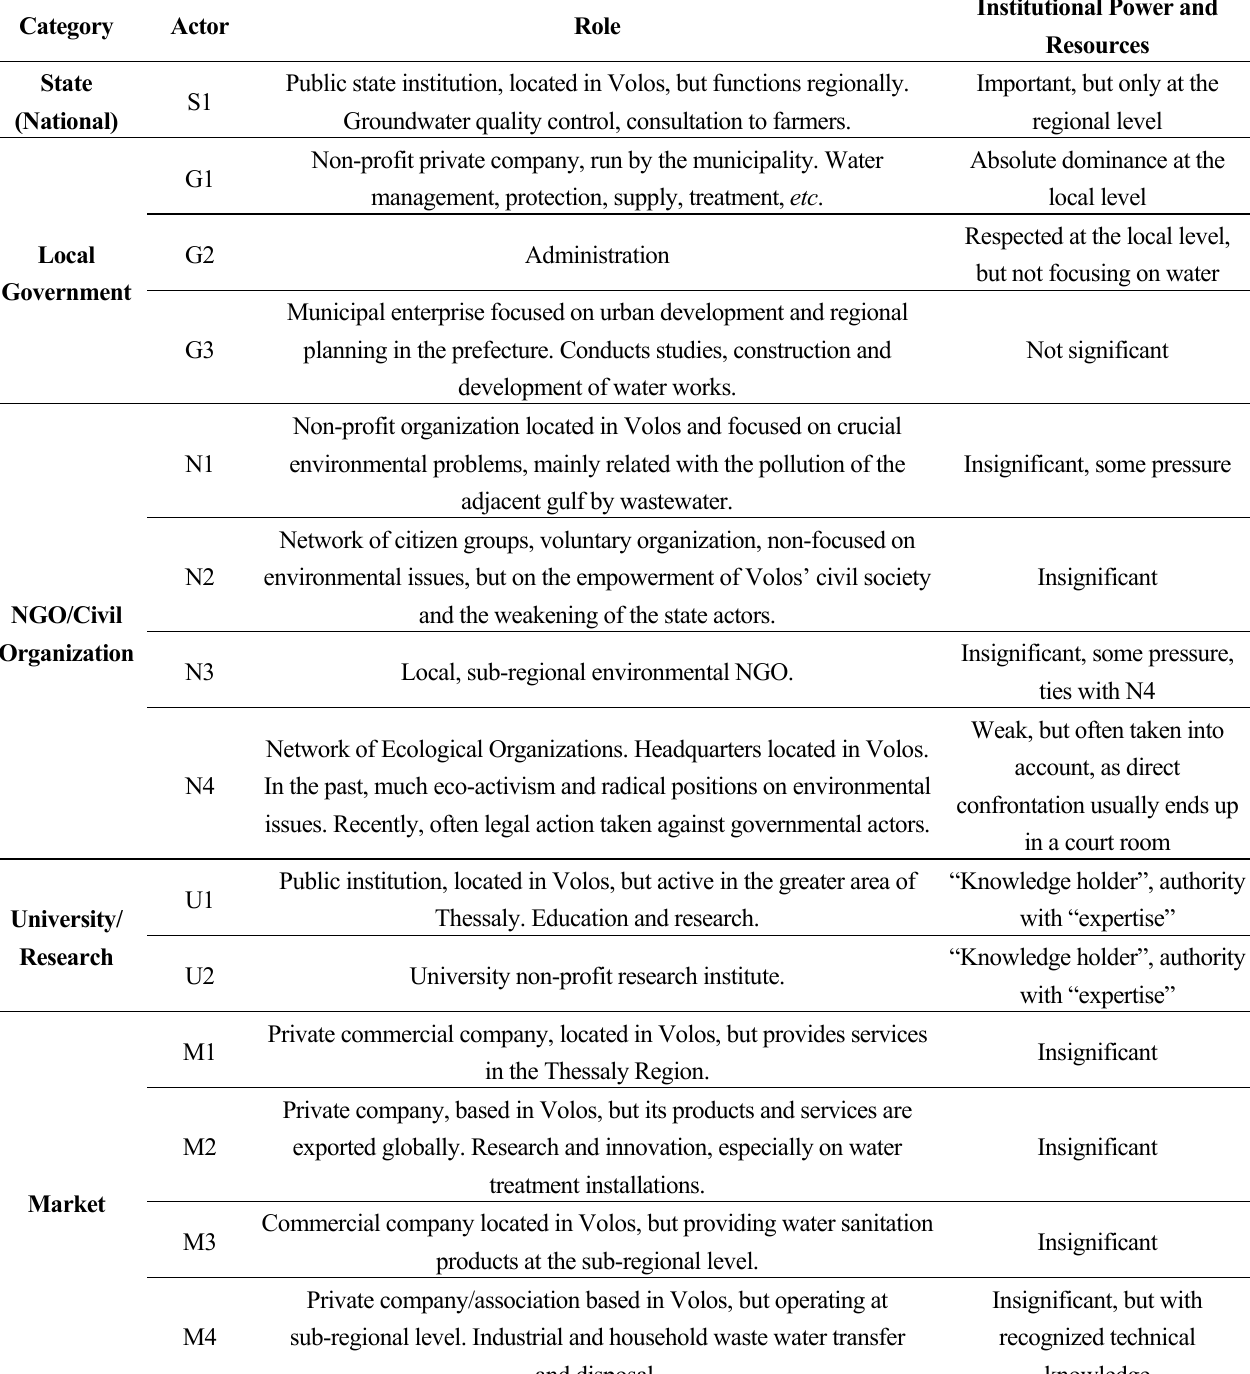
Table 1. The fourteen organizations that participated in the process of change (adopted by